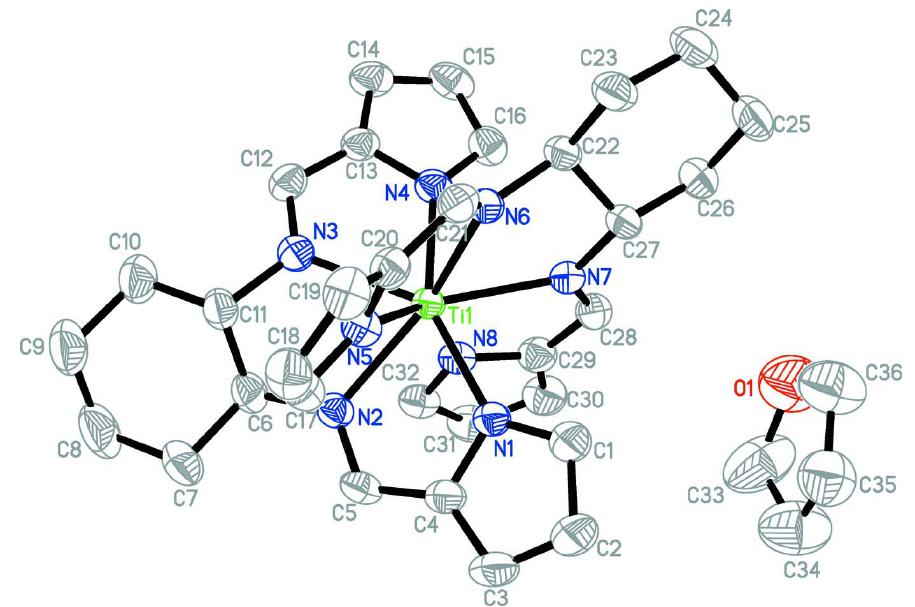
The molecular structure of the title compound. Displacement ellipsoids are drawn at the 50% probability level. H atoms have been omitted for